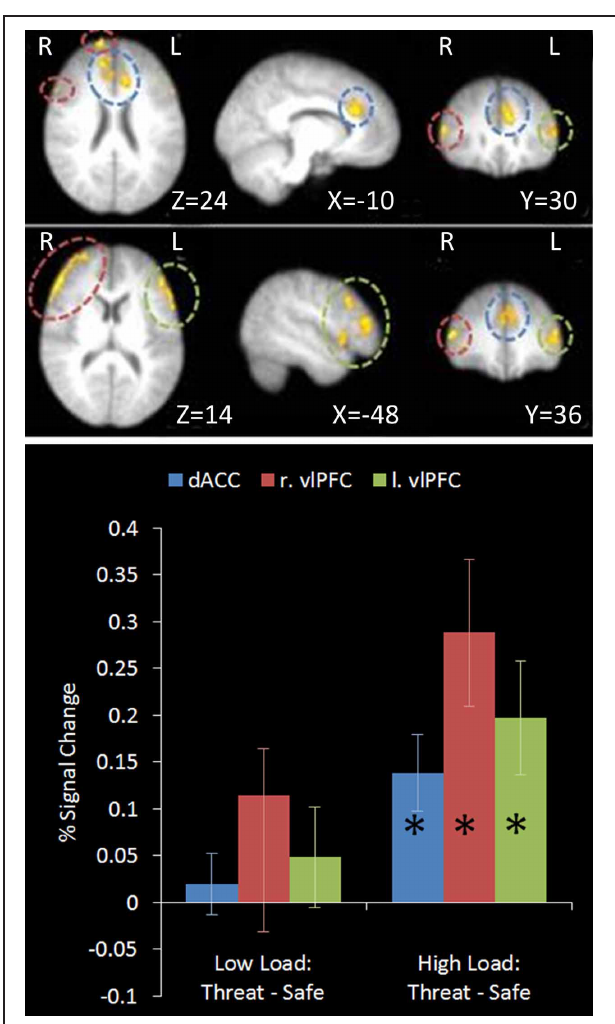
FIGURE 5 | Top: Top-down control contrast imaging results. This contrast revealed areas where activation was greater under High Load/Threat conditions compared to all others. Three clusters were identified: Dorsal ACC as well as bilateral PFC. Medial (upper panel) and lateral (lower panel) views are displayed. Bottom: Pairwise comparisons of the signal change in the regions identified. Activation in all three clusters was greater under threat compared to safety under the equivalent working memory loads, however this increase was only significant under High Load [cingulate: High Load/Threat—High Load/Safe: mean difference = 0.139%, S . D = 0 . 122, t ( 17 ) = 4 . 838, p < 0 . 001; left vlPFC: High Load/Threat—High Load/Safe: mean difference = 0.197%, S . D = 0 . 181, t ( 17 ) = 4 . 614, p < 0 . 001; right vlPFC: High Load/Threat—High Load/Safe: mean difference = 0.288%, S . D = 0 . 236, t ( 17 ) = 5 . 176, p < 0 . 001]. Error bars display within-subject standard error (Morey, 2008). ∗ p < 0 . 05 (two-tailed).